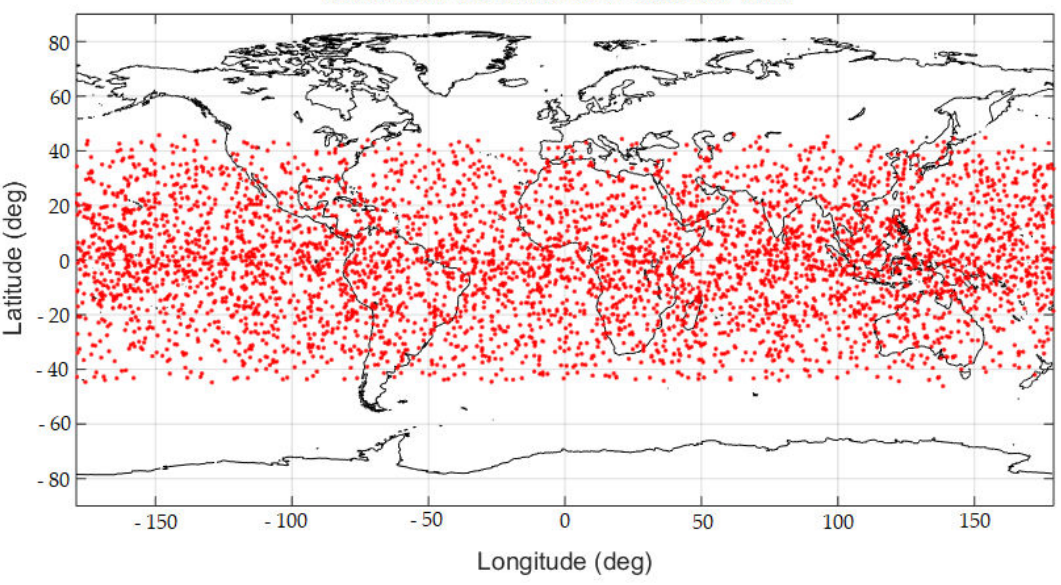
Figure 3. Data distribution for 24 h coverage by FORMOSAT-7/COSMIC-2 (FS-7)